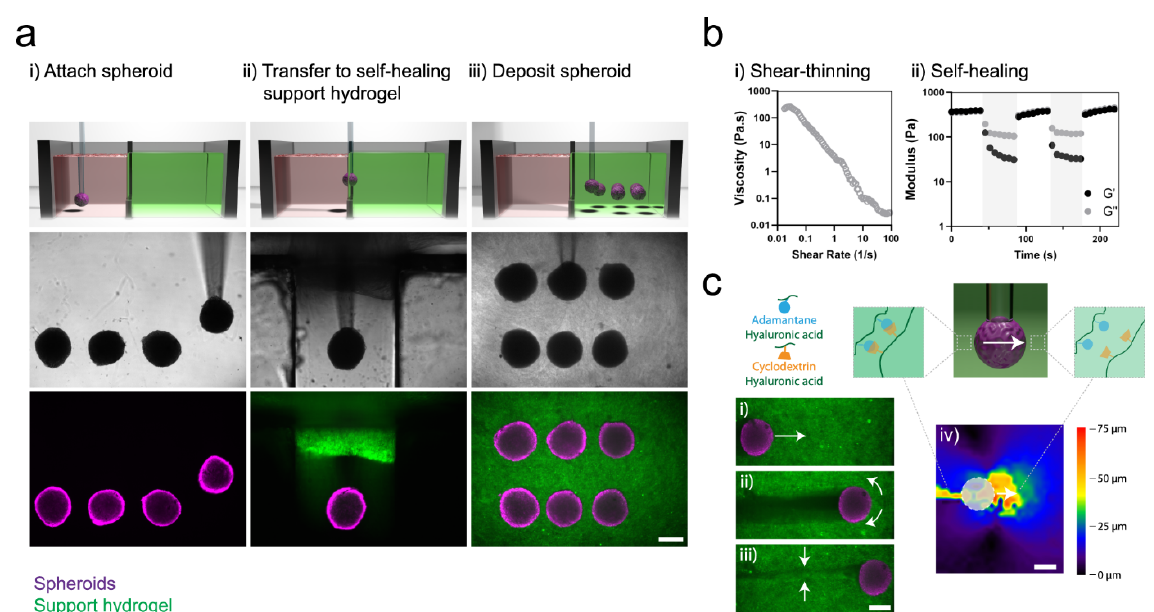
Figure 13. ( a ) Schematic, brightfield and fluorescent images (top, middle, bottom respectively) of ( i ) formation of spheroid loaded with MSC in support bath, ( ii ) transfer of spheroid to self-healing support hydrogel followed by ( iii ) deposition of spheroid within support hydrogel. ( b ) Rheological characterization and demonstration of ( i ) shear thinning properties of the guest-host support self-healing hydrogel. ( ii ) self-healing properties: storage modulus and loss modulus. ( c ) demonstration of reversible interactions between spheroid and support hydrogel. ( i , ii ) yielding of the support hydrogel post spheroid translation and the resulting ( iii ) rapid healing of the support hydrogel after spheroid translation. ( iv ) mapping the displacement of the support hydrogel highlighting the local motion of the hydrogel around the spheroid. (Reproduced with permission from Ref. [193] under Creative Commons Attribution License (CC BY)).